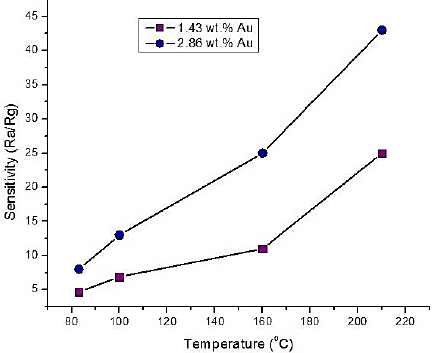
Figure 11. Sensitivity of two different Au doped SnO 2 thick films at different temperatures.